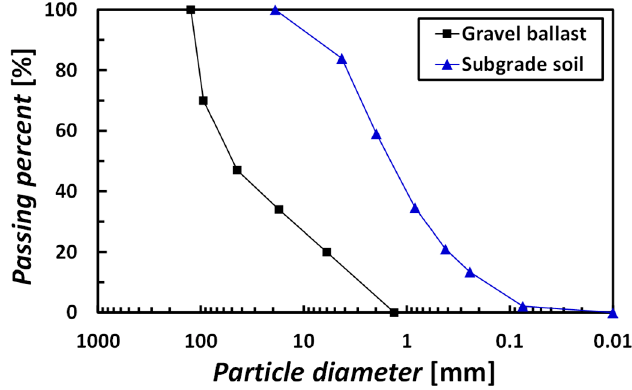
Figure 2. Grain size distributions of gravel ballast and subgrade soil.